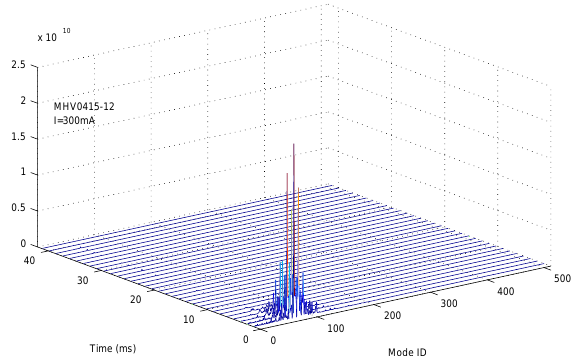
FIG. 11. (Color) Example of a damped transient due to a vertical instability in the KEKB